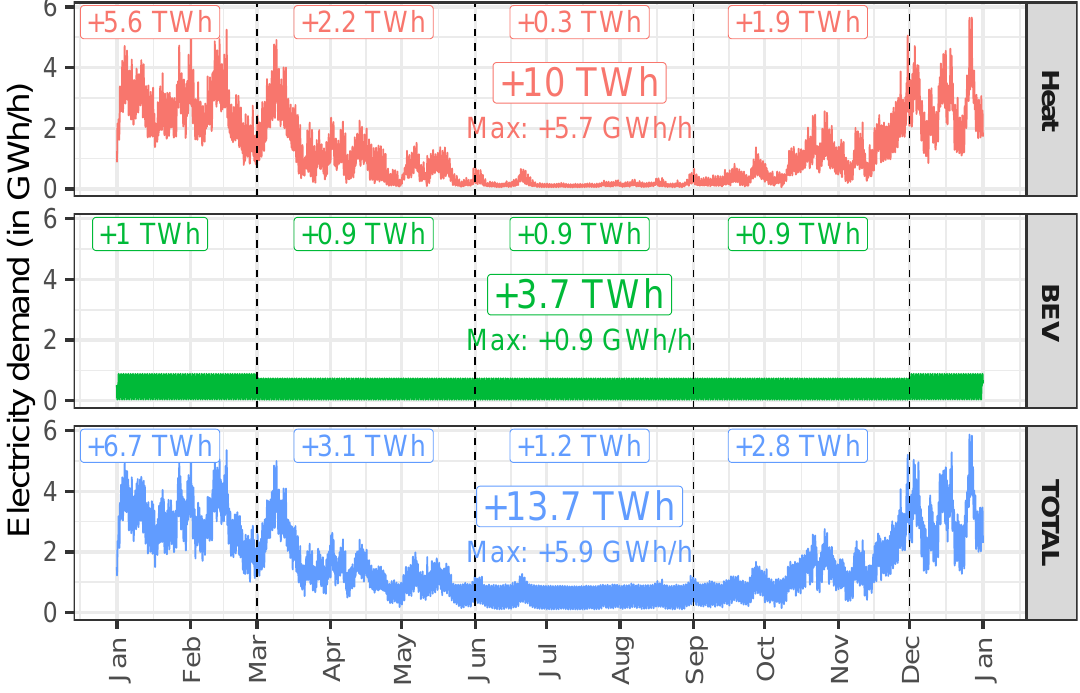
Figure 12. Additional hourly electricity demand of an electrification of the Swiss heat (SH and DHW) and mobility sector with 75% heat pumps and 20% BEV. Seasonal and annual sums are displayed in